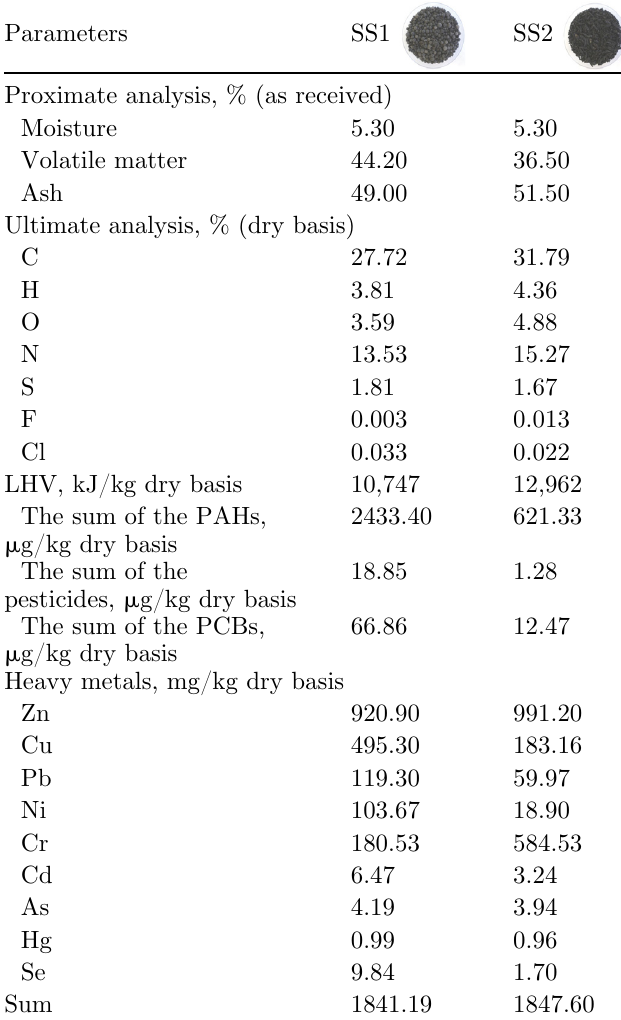
Table 1. Properties of the fuel